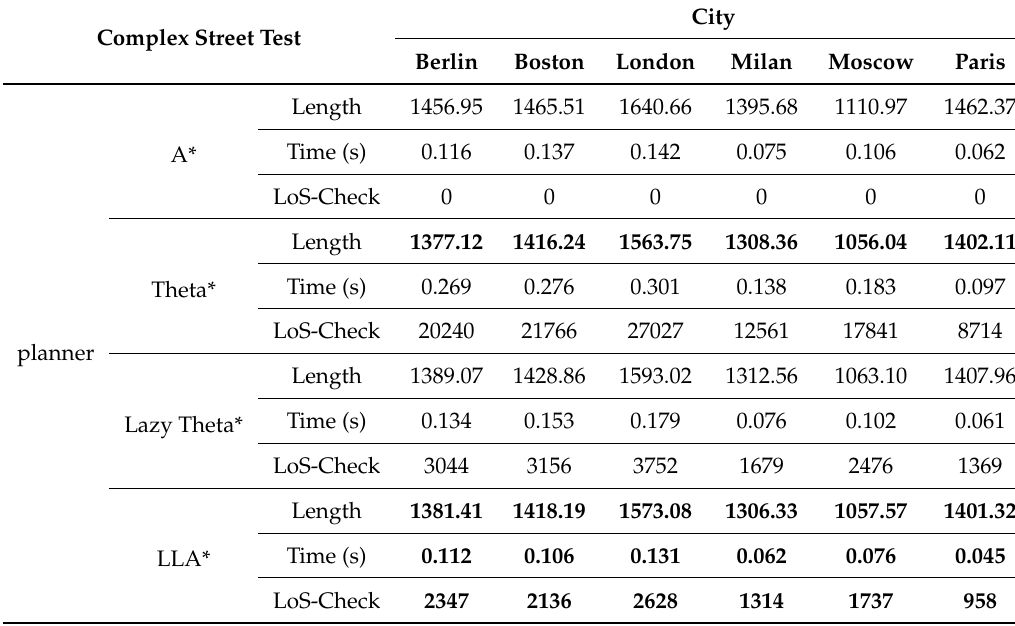
Figure 8. The path planning results using the LLA* algorithm on six complex street maps. These street maps were chosen from the benchmark maps in Section 6.1, and they are thumbnails of the real streets in six different cities. The size of these maps is 1024 × 1024. The start position and goal position are both set at some narrow corners, making the planning task more difficult to solve. The final paths are shown as orange solid lines. Table 2. Path planning results on six complex street